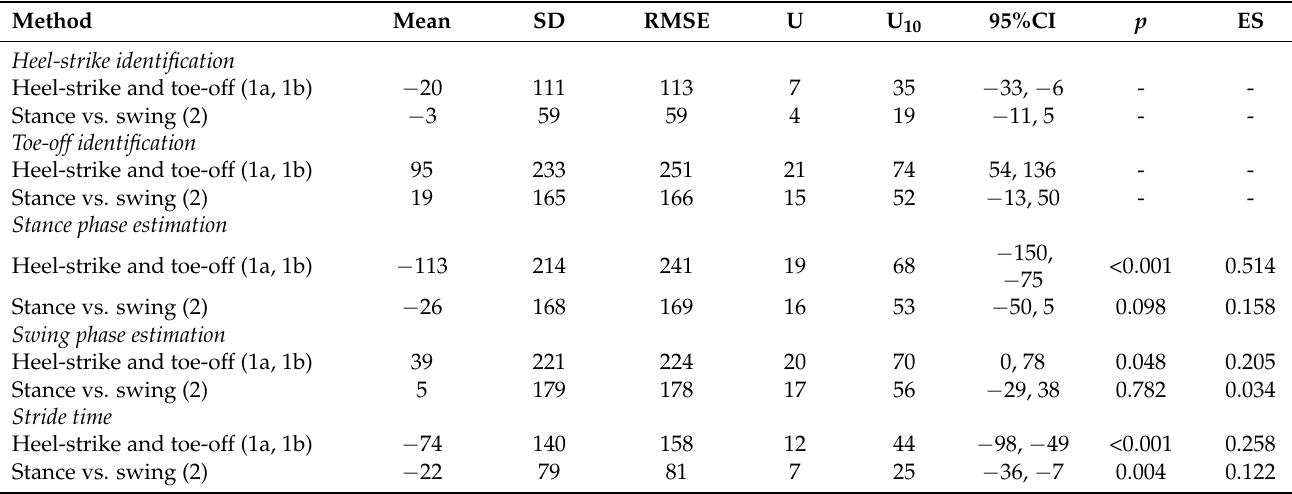
Table 3. Descriptive statistics (in ms) of the heel-strike and toe-off identification, as well as swing/stance/stride time estimation, with respect to the reference system (force platform).